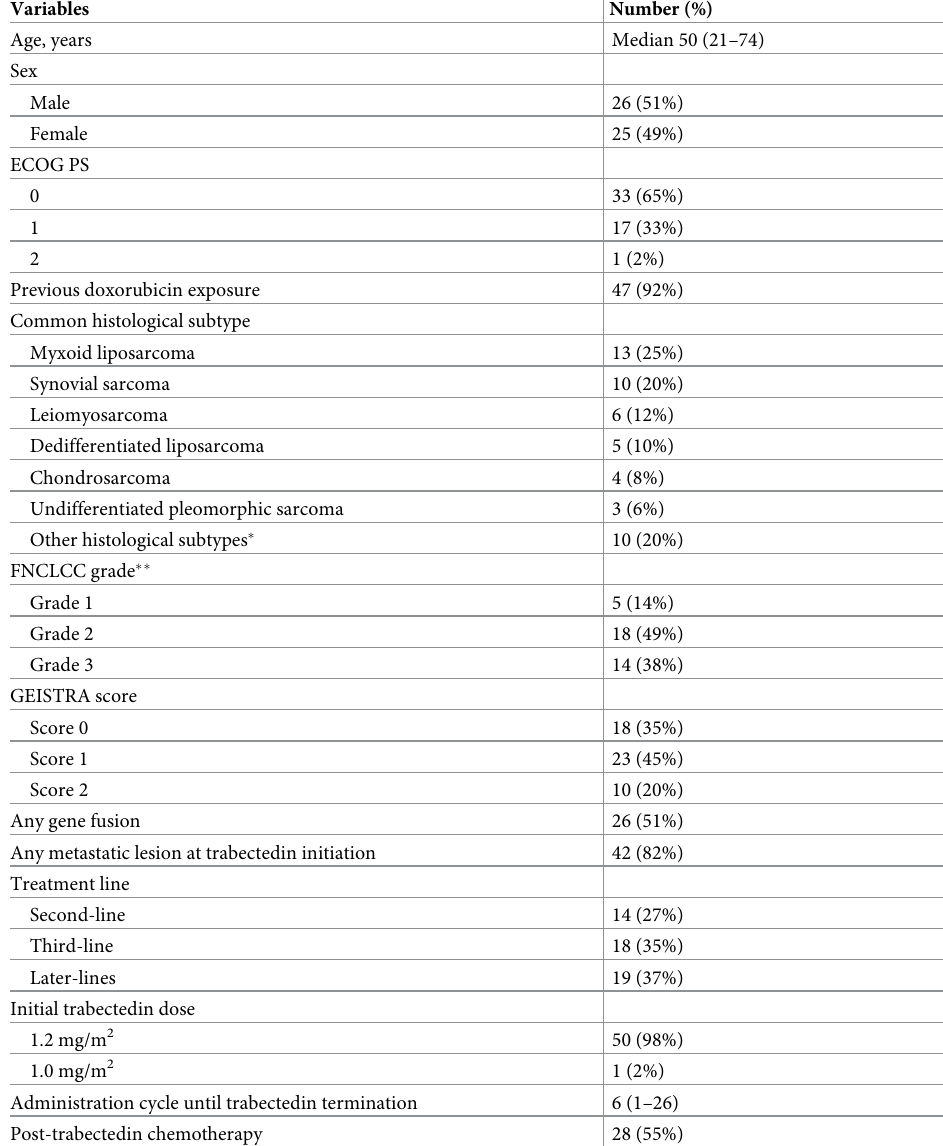
Table 1. Clinical characteristics of 51 sarcoma patients who received